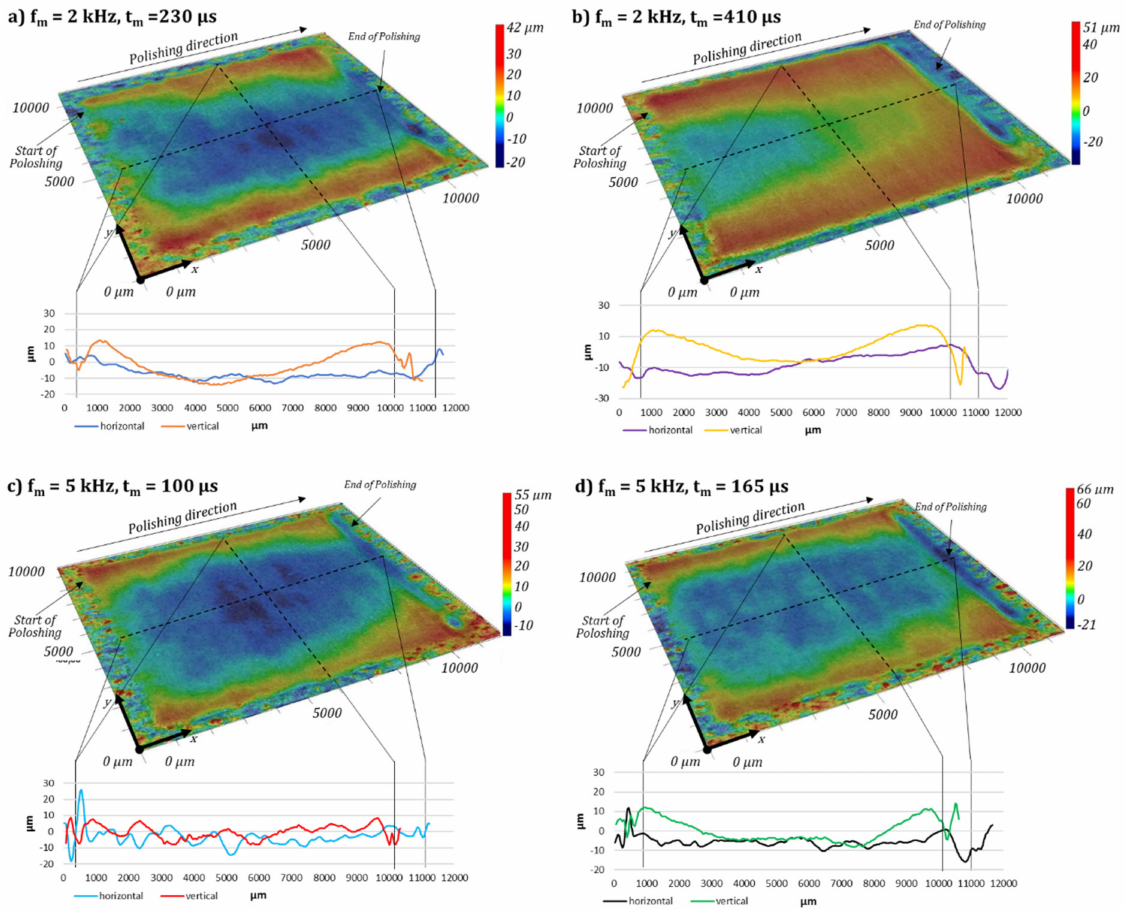
Figure 13. Fold magnification of the 3D topography of the laser polished surface structures with a modulation frequency of f m = 2 kHz ( a , b ) and f m = 5 kHz ( c , d ) depending on the modulation time t m